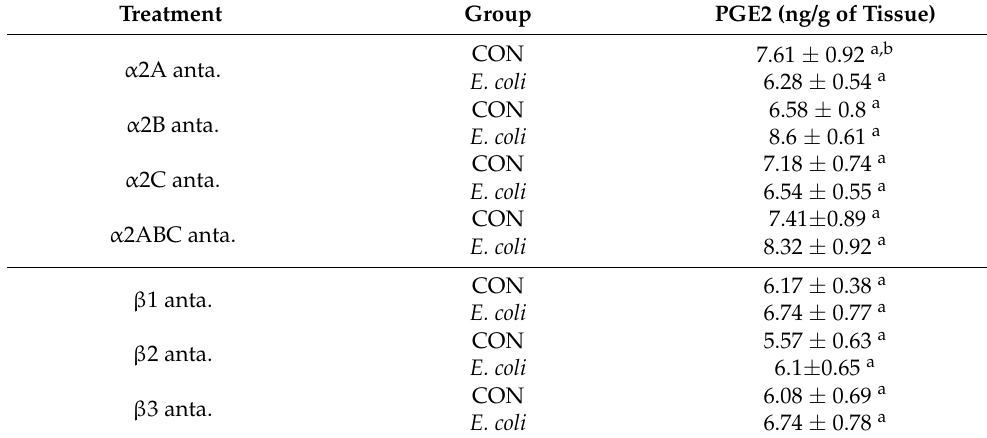
Table 2. Cont. Treatment